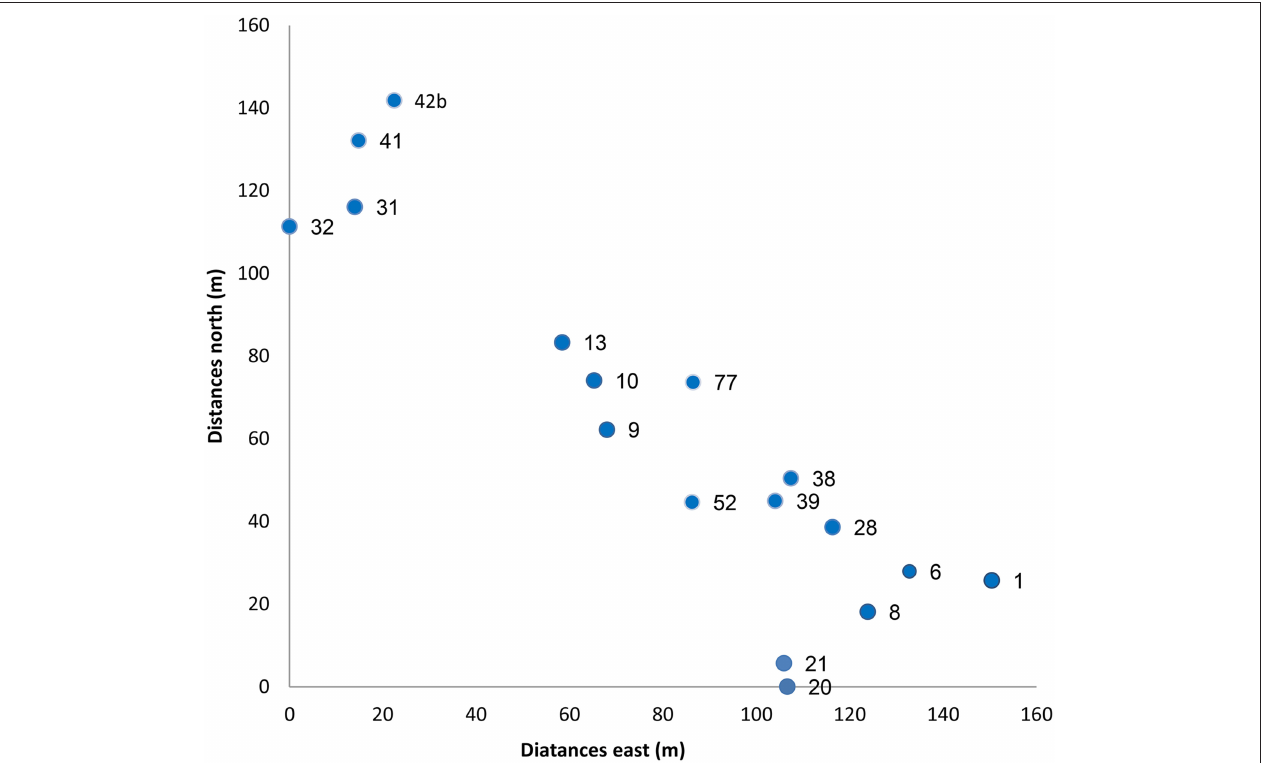
FIGURE 1 | Spatial location of the sampled trees (distances are in meters). The numbers next to each dot represent the number of the burned trees and their seedling